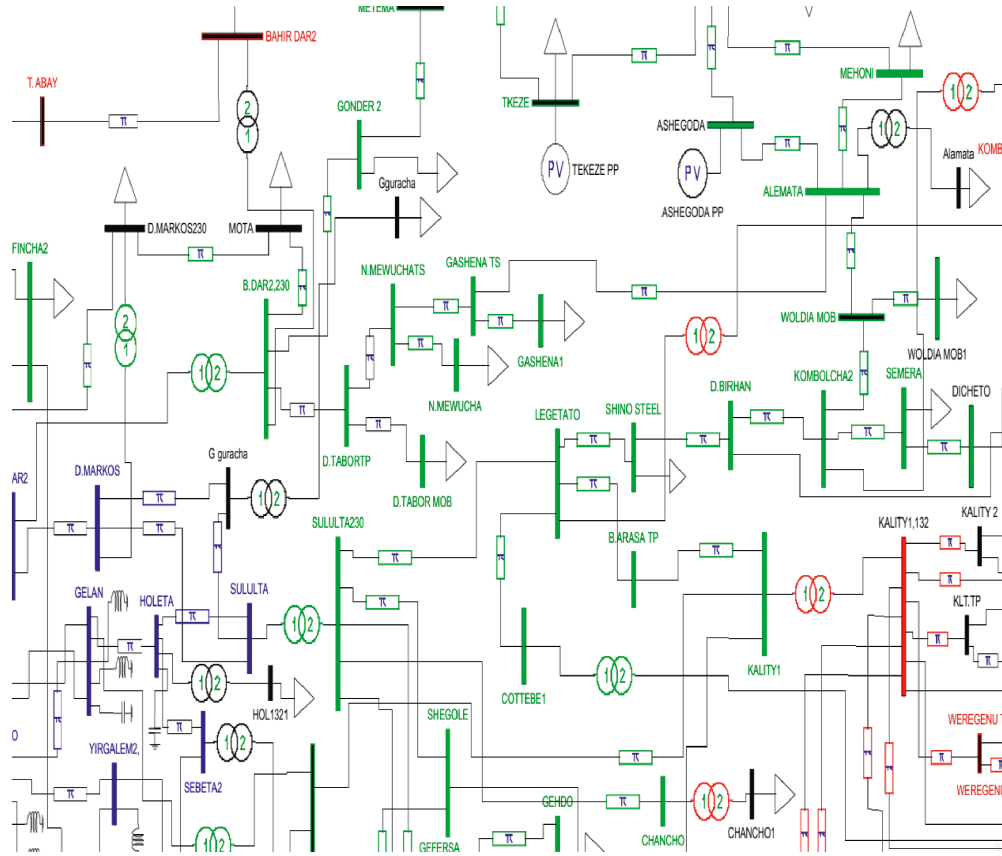
Figure 1: Modeling of Ethiopian Electric Power